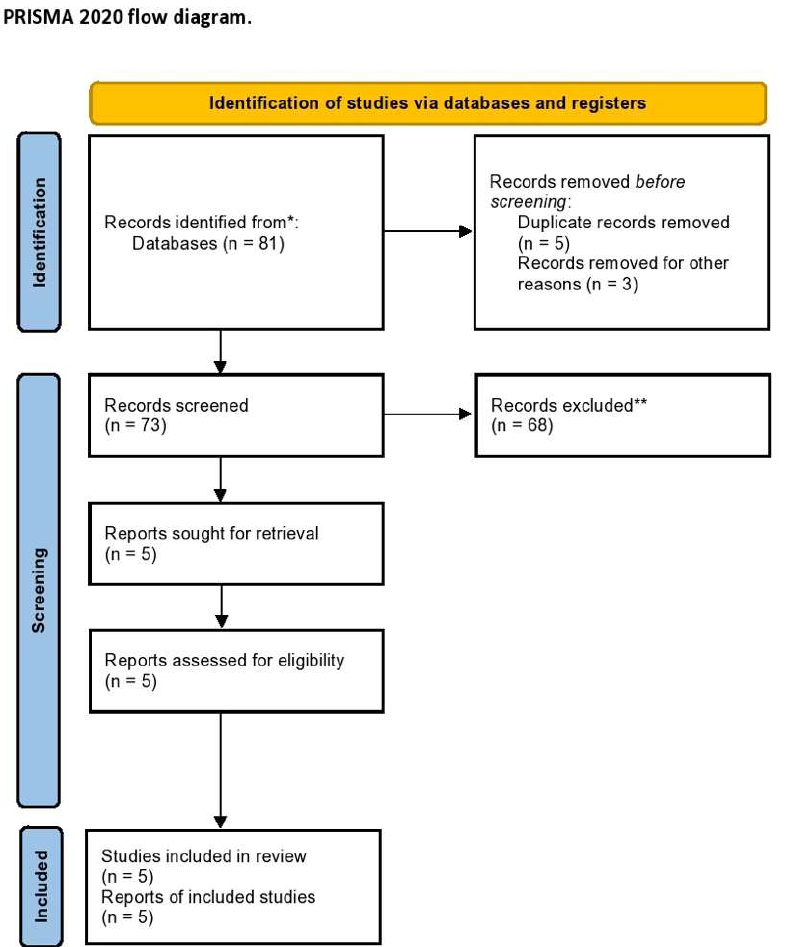
Figure 1. PRISMA flow diagram of the systematic literature search. * MEDLINE, EMBASE, Global Health, The Cochrane Library (Cochrane Database of Systematic Reviews, Cochrane Central Register of Controlled Trials, Cochrane Methodology Register), Health Technology Assessment Database and Web of Science, and Clinical Trials; ** Records excluded by a human and automation